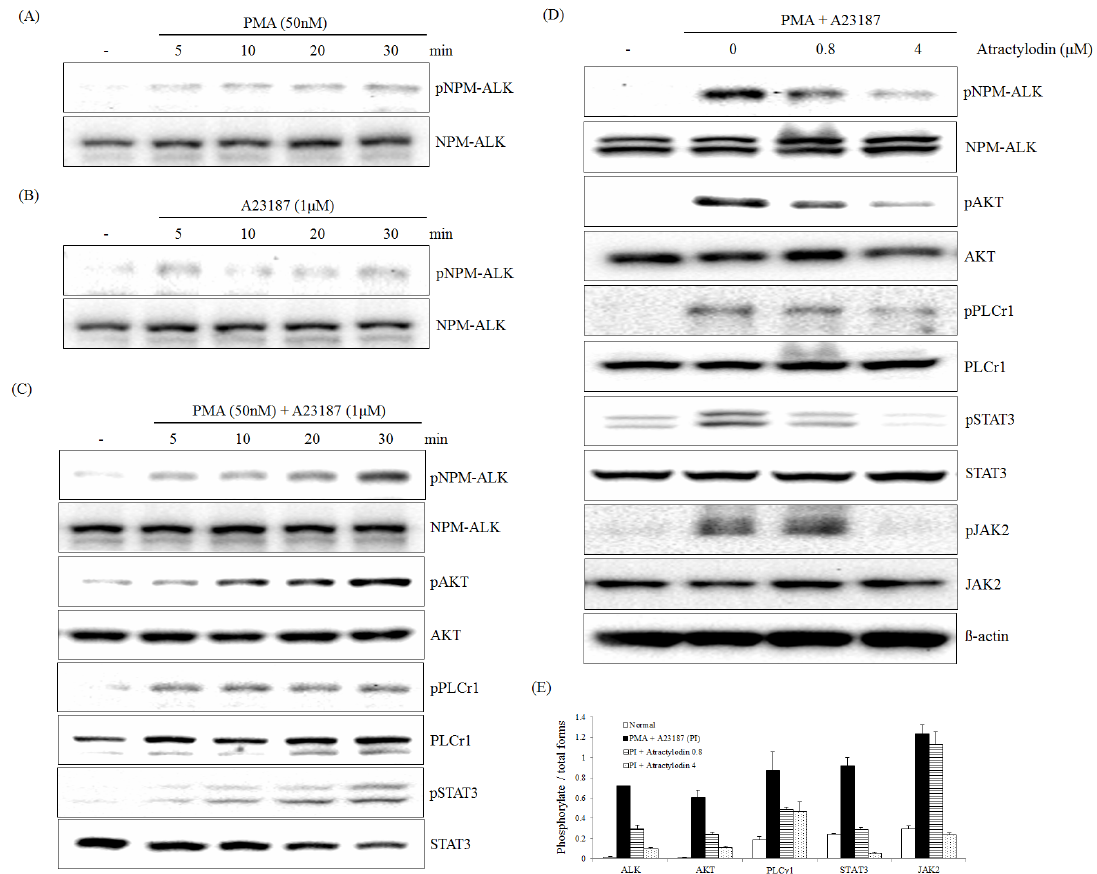
Figure 2. Effect of atractylodin on the PMA plus A23187-induced activation of the NPM-ALK pathway in HMC-1. HMC-1 was treated with PMA at the indicated times for 50 nM and phospho (Tyr646)- and total NPM-ALK were detected by immunoblot analysis ( A ); HMC-1 was treated with A23187 at the indicated times for 1 µ M and phospho (Tyr646)- and total NPM-ALK were detected by immunoblot analysis ( B ); HMC-1 was treated with PMA plus A23187 at the indicated times for 50 nM and 1 µ M and phospho- and total NPM-ALK, AKT, PLC γ 1 and STAT3 were detected by immunoblot analysis ( C ); HMC-1 was treated with the indicated concentrations of atractylodin for 0.5 h prior to being incubated with PMA (50 nM) plus A23187 (1 µ M) for 0.5 h and phospho and total NPM-ALK, AKT, PLC γ 1, JAK2, and STAT3 were detected by immunoblot analysis as described in Materials and Methods ( D ); The immunoblot signals were quantified using Molecular Analyst/PC densitometry software (Bio-Rad). Densitometric analysis of phosphorylated isoforms is reported ( E